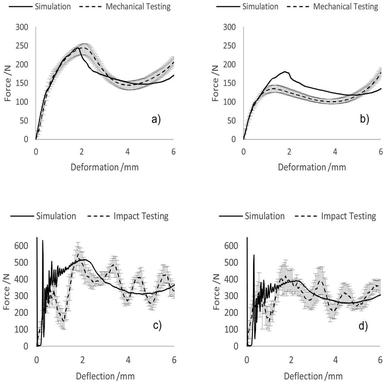
Honeycomb validation, plotting mechanical test data alongside related simulations: a) Primary quasistatic, b) Stabilised quasistatic, c) Primary impact, d) Stabilised impact. Error bars = SD.